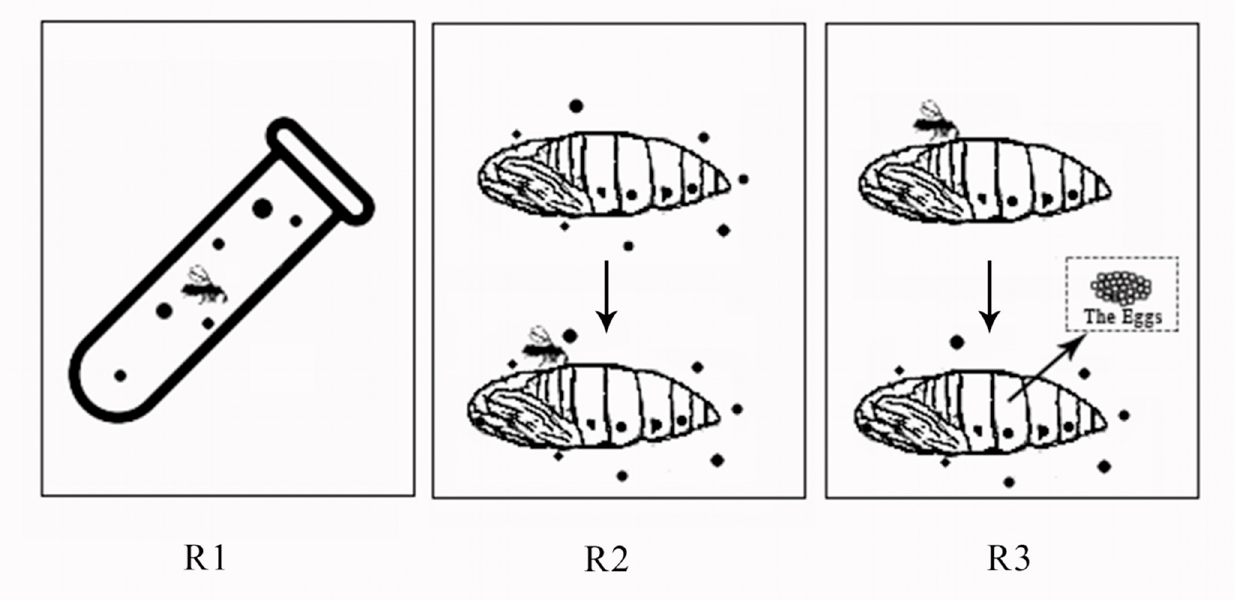
Figure 1. R1 (Routes of exposure 1) is adult exposure to pesticide residues on the glass tube; R2 (Routes of exposure 2) is adult exposure to pesticide residues on the host; and R3 (Routes of exposure 3) is larval exposure to pesticides through host exposure.